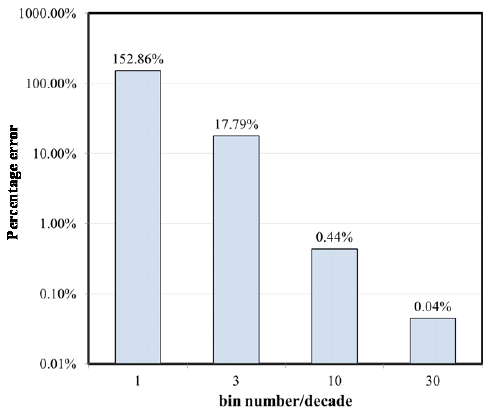
Figure 2: Dependence of computation precision on bin resolution (number of bins per decade change Fig. 2. Dependence of computation precision on bin resolution in size) for intra-modal coagulation rates. The errors are calculated by comparing with the 100 bins (number of bins per decade change in size) for intramodal coag- ulation rates. The errors are calculated by comparing with the 100- per decade results. bins-per-decade